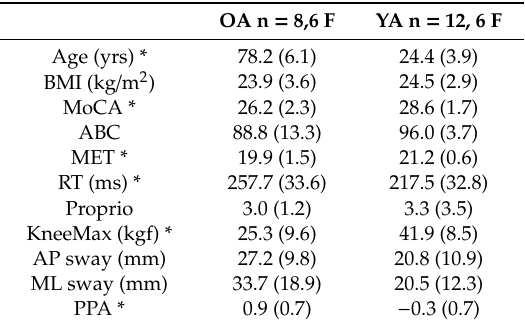
Table 1. Participant characteristics (mean and standard deviation). * indicates the significant group di ff erence ( p <